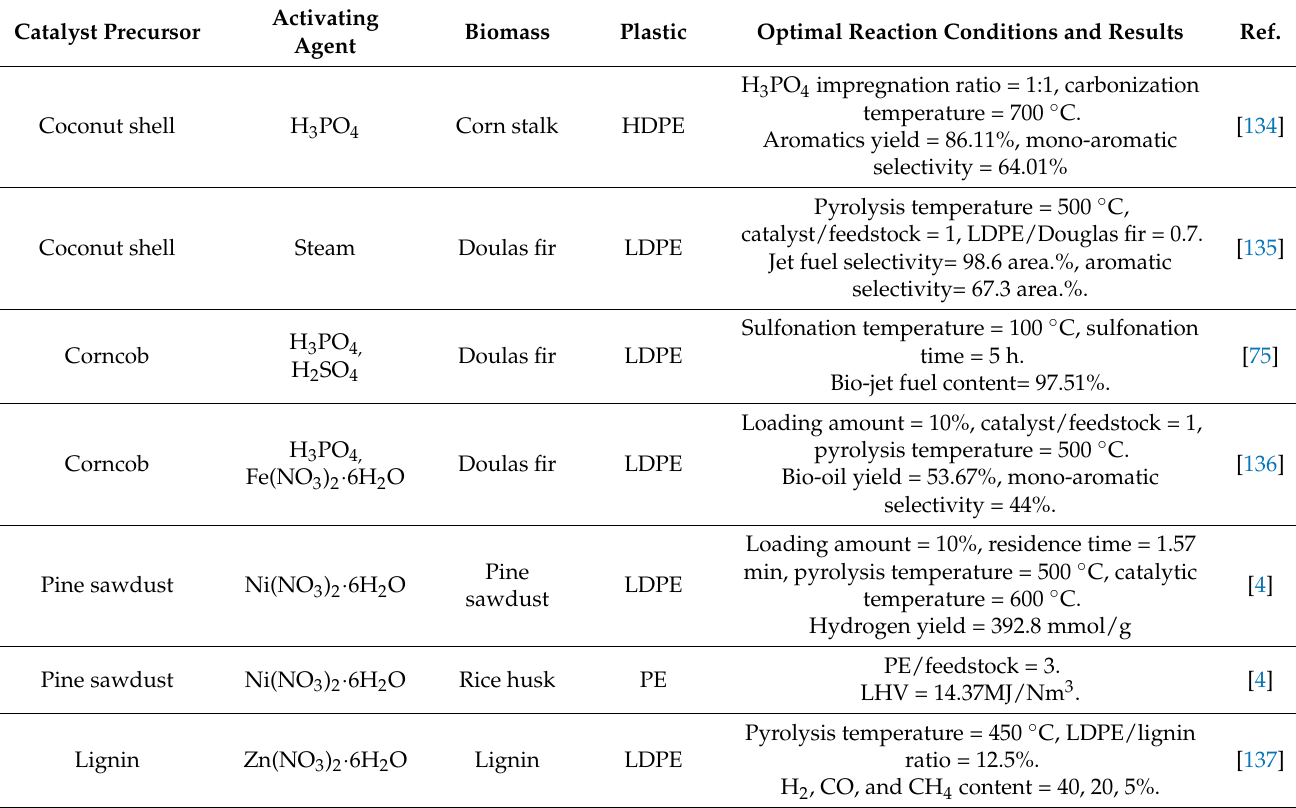
Table 5. Optimal reaction conditions and results of catalytic co-pyrolysis of LB and WPs with